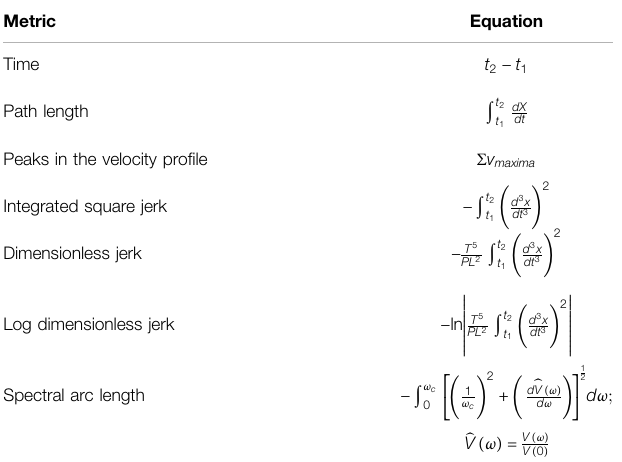
TABLE 1 | List of commonly used process metrics for evaluating skilled motion. Several previous studies have used these metrics for various clinical